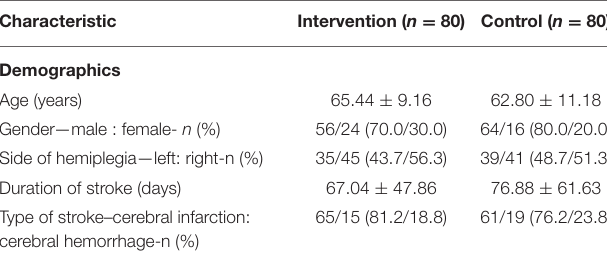
TABLE 1 | General characteristics of the two groups by randomization assignment.